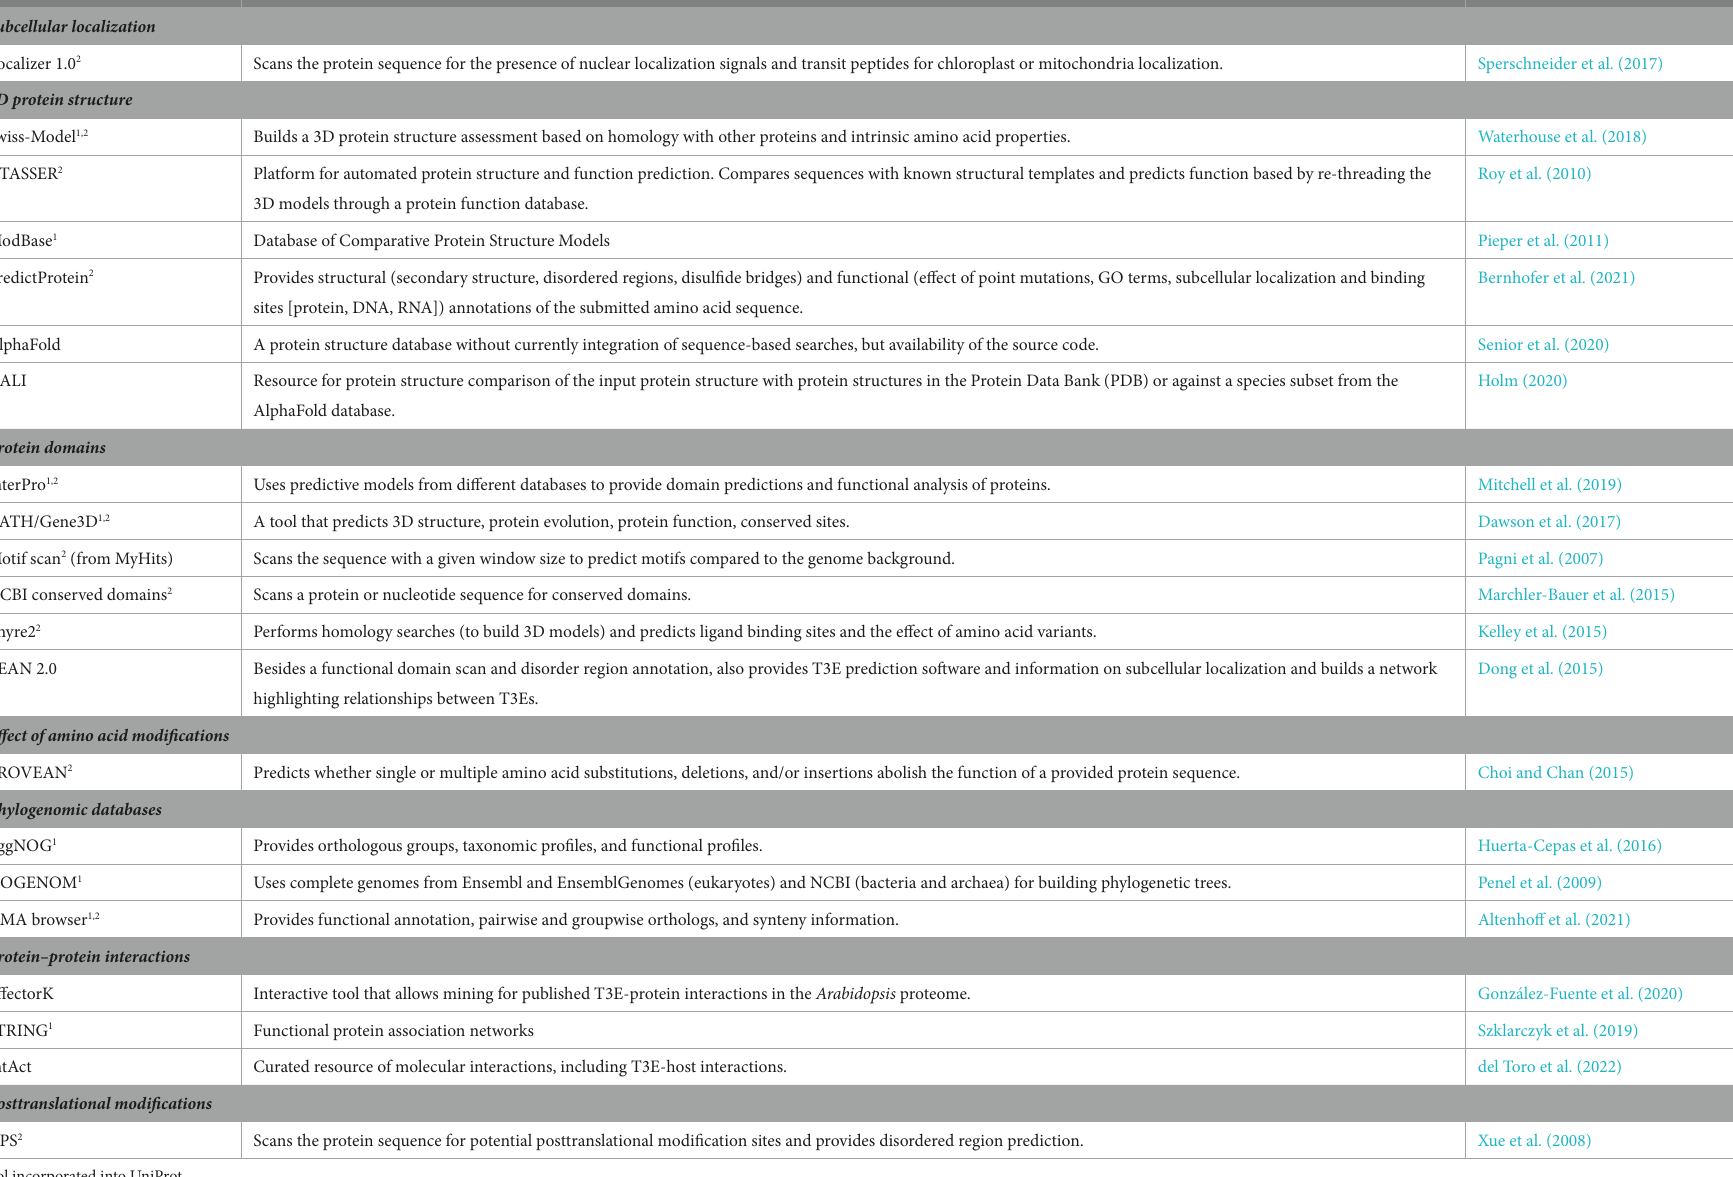
TABLE 1 Freely available online tools to aid in characterizing a predicted